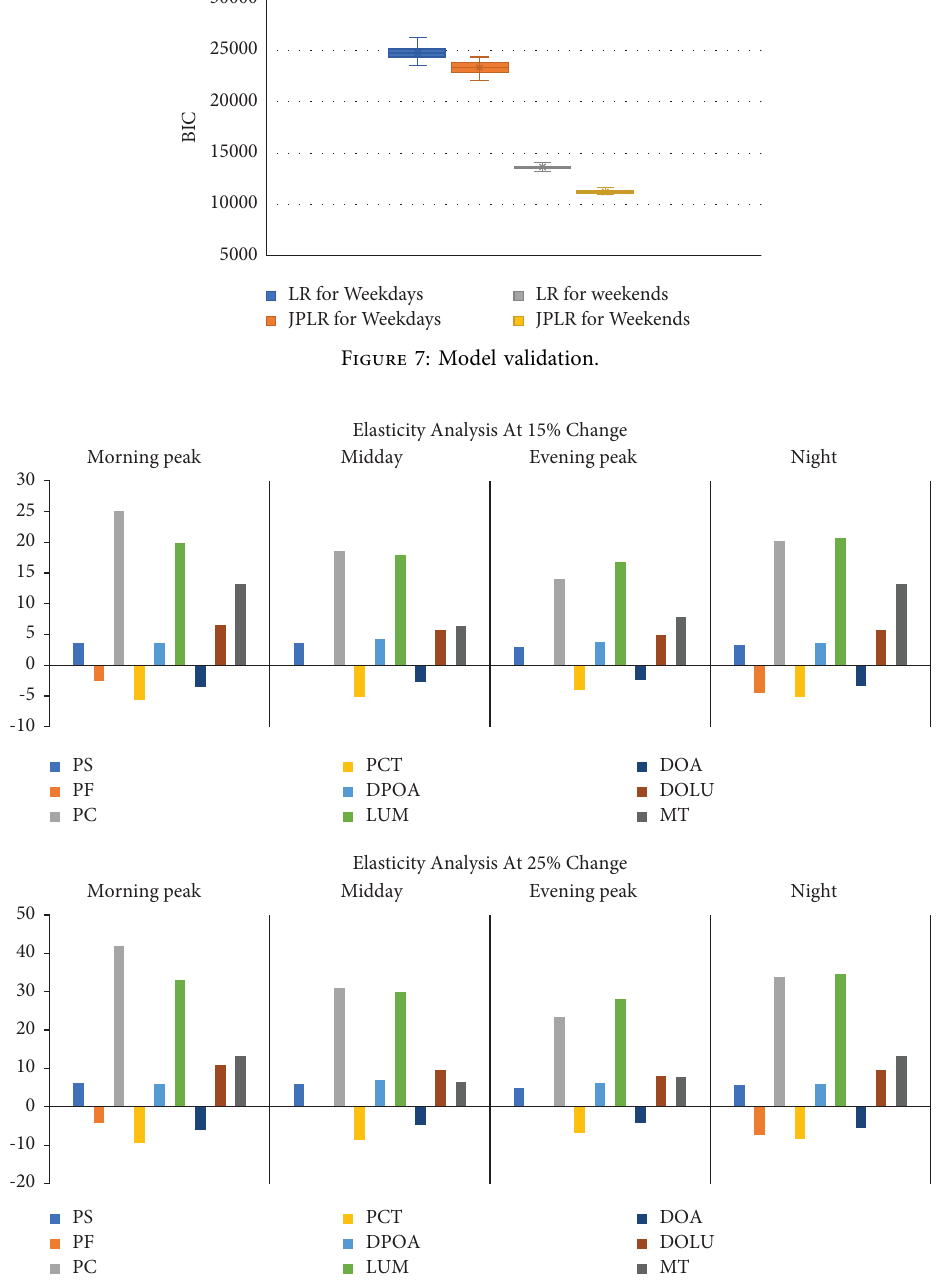
Figure 8: Elasticity analysis for weekdays. Note . PS � proportion of students, PF � proportion of female, PC � proportion of commuters, PCT � proportion of commuters using who public transit, DPOA � density of park and open space area, LUM � land use mix, DOA � density of ofce area, DOLU � density of other land use area, MT � medium